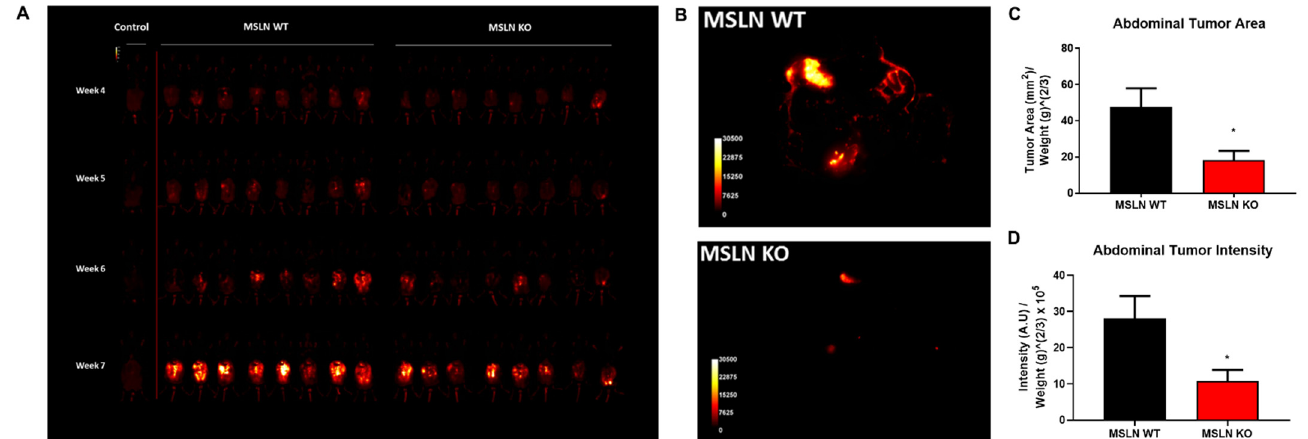
Figure 5. In vivo and in situ tumor burden of MSLN WT and MSLN KO mice. ( A ) 3–6 month aged cohorts were injected i.p. with 7 × 10 6 ID8 ovarian cancer cells tagged with RFP. Mice were imaged under anesthesia at 4-, 5-, 6- and 7-weeks post-injection to monitor tumor progression using a Bruker Xtreme In Vivo imaging system. The live imaging data suggested MSLN KO mice had less tumor burden compared with MSLN WT mice. ( B ) At 8 weeks post-injection, end point dissection was performed. The abdominal cavity was exposed and the entire body was imaged using the Bruker Xtreme In vivo imaging system. ( C ) Abdominal tumor burden was quantified with ImageJ using two parallel methods of analysis. Abdominal Tumor Area (the tumor area divided by a scale-adjusted weight of the animal) and ( D ) Abdominal Tumor Intensity (the fluorescence intensity of the tumors divided by a scale-adjusted weight of the animal) both demonstrated that MSLN KO mice develop significantly less tumor burden than MSLN WT mice. n = 8 for both MSLN WT and MSLN KO ; * p < 0.05; error bars represent standard error of mean.